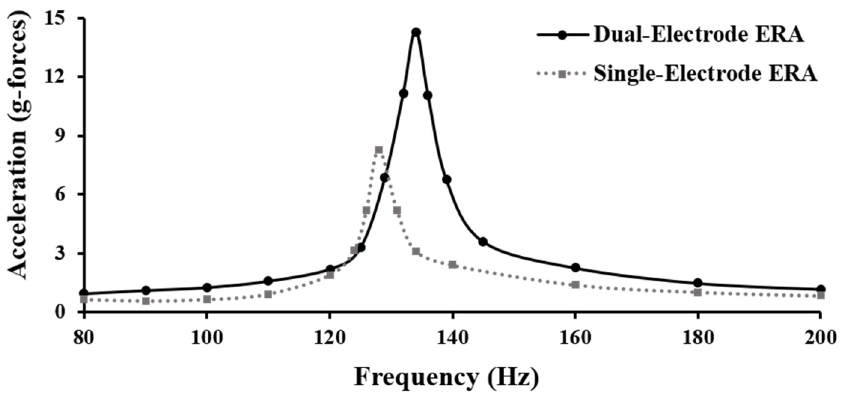
Figure 7. Experimental acceleration response of single-electrode actuator and dual-electrode actuator. Appl. Sci. 2020 , 10 , x FOR PEER REVIEW